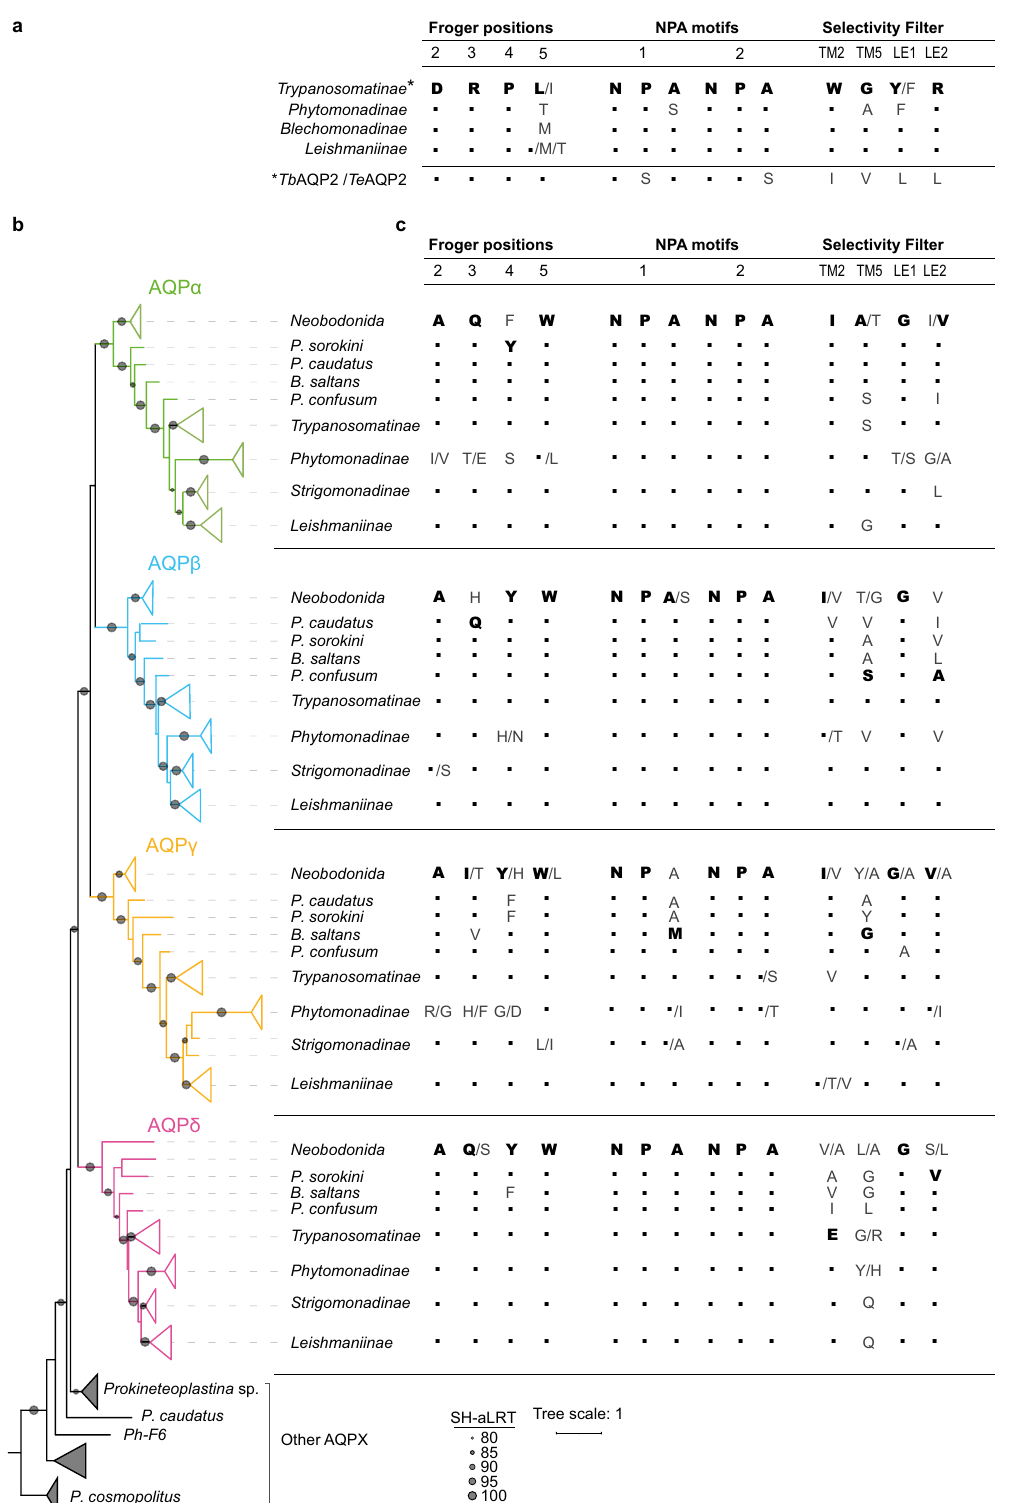
Fig. 7 Key MIP residues from GLP and AQPX subfamilies. Froger positions, NPA motifs and Selectivity fi lter residues of Discoba a GLPs and b , c AQPXs. The most frequent amino acid of a particular position in each clade is shown in bold fi rst and then with dots. b Collapsed Discoba AQPXs phylogenetic tree reconstructed by maximum likelihood. c Analysis of